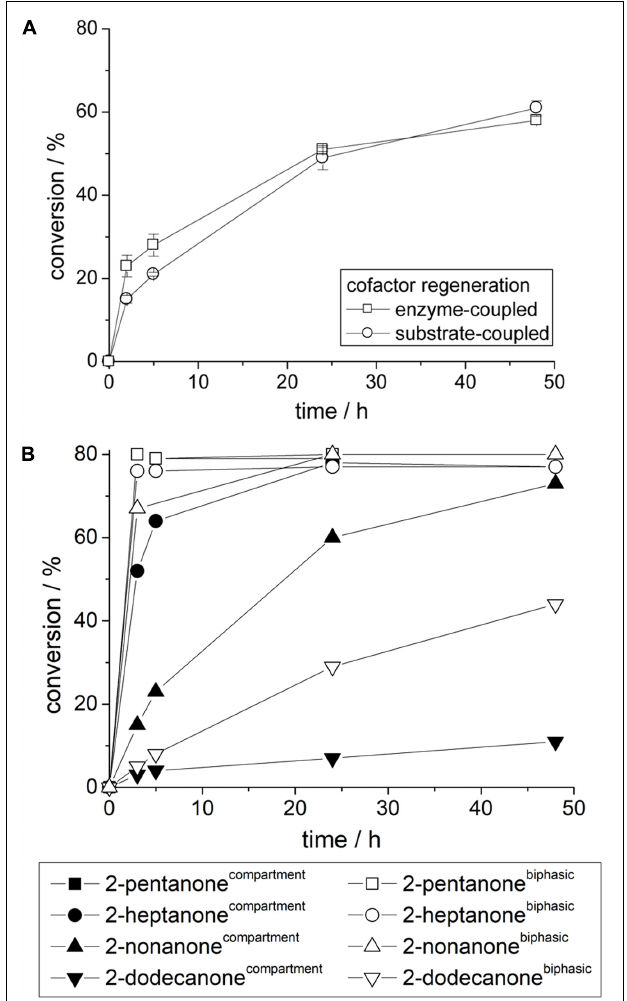
FIGURE 5 | (A) Reaction of compartmented Lk ADH with enzyme-coupled and substrate-coupled cofactor regeneration. (B) Comparison of compartmented Lk ADH and a classical biphasic system for the conversion of various prochiral aliphatic ketones; Reaction conditions: Compartmented Lk ADH: 10 mM substrate, 100 mM 2-propanol in 5 mL MTBE (external solvent); biphasic reaction system: 10 mM substrate, 100 mM 2-propanol in